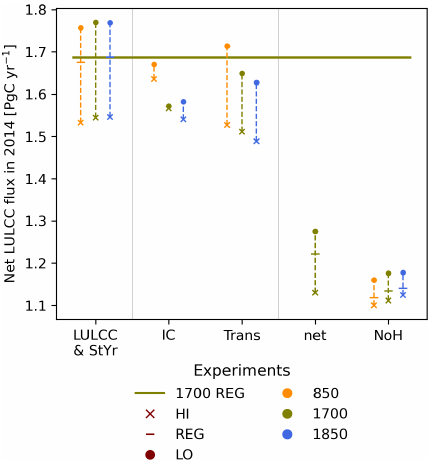
Figure 6. Global annual net LULCC flux in 2014. Although the overall layout is as in Fig. 3, the y axis is not scaled by a reference simulation but presents the total net emissions in 2014. Note that the experiment groups (LULCC and StYr) are now combined as the presented values show the absolute net LULCC